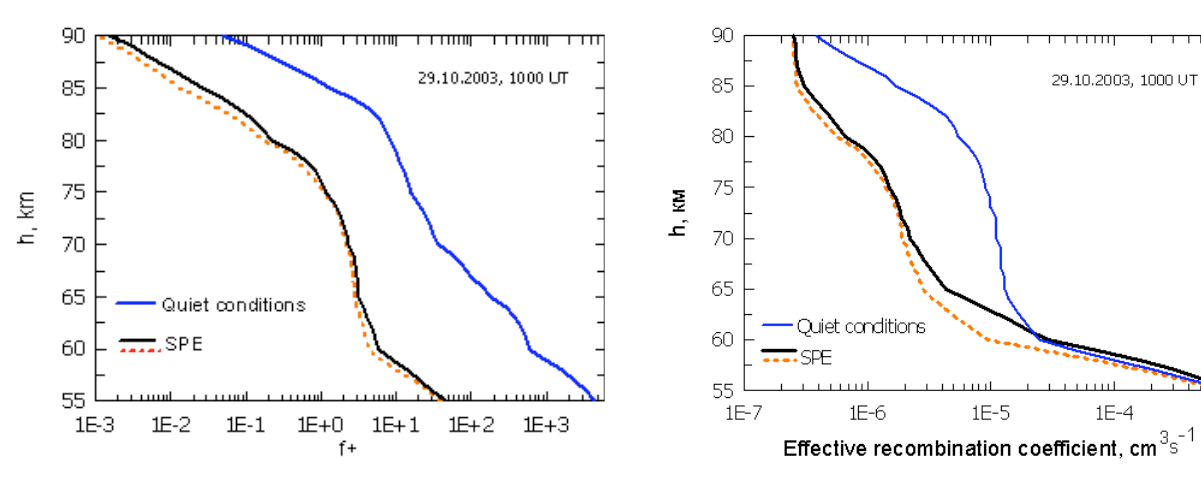
Fig. 8c. α eff profiles calculated for quiet conditions (blue curve) using the O, O 3 and NO profiles 1–3 in Fig. 1 and for the SPE on 29 October 2003 at 10:00UT using-profiles 4–6 in Fig. 1 (black curve) and 1–3 in Fig. 1 (red dashed